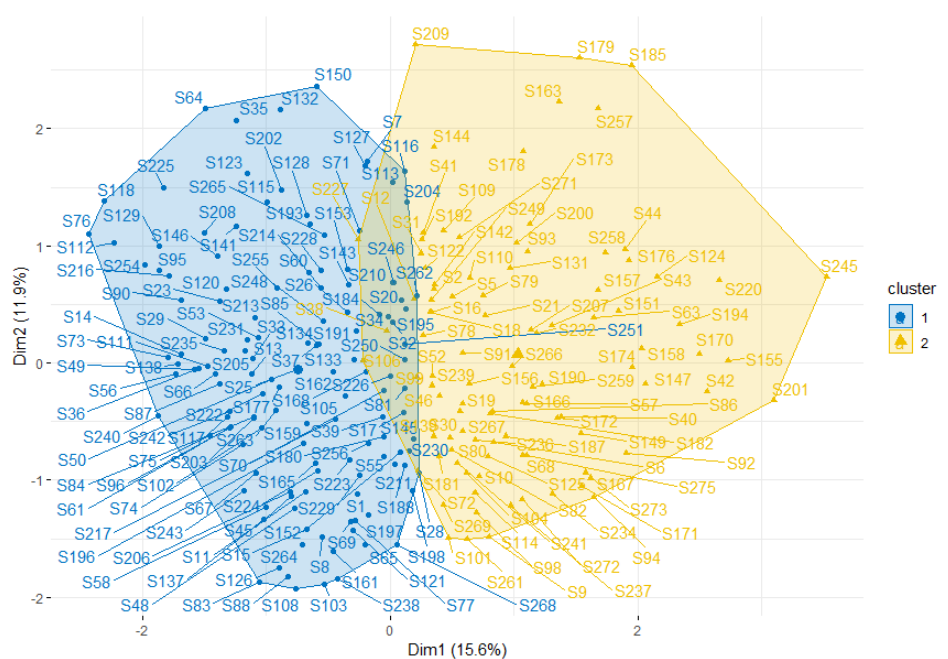
Figure 2. Hierarchical clustering based on multiple factor analysis (MFA) summarising and visualising the data in two-dimensional plots. The blue cluster consists mainly of general secondary (GSE) schools and the grey cluster mainly represented vocational / technical secondary education (VSE) education (GSE) schools and the grey cluster mainly represented vocational/technical secondary schools. Row points with a similar profile are closed on the factor education (VSE) schools. Row points with a similar profile are closed on the factor map.